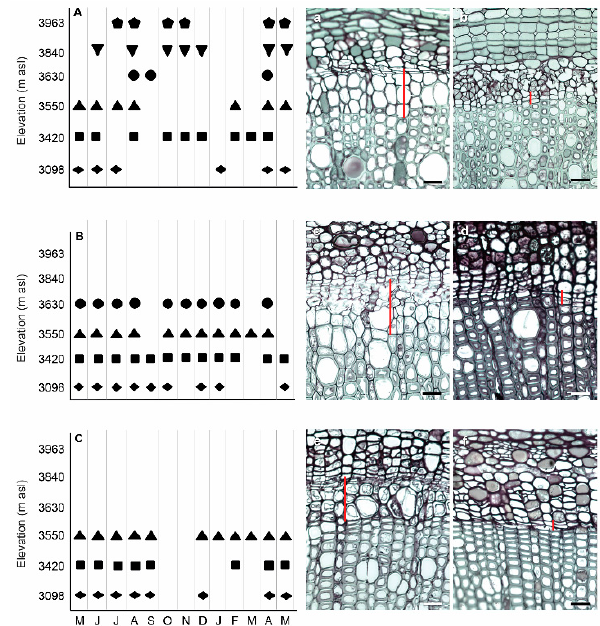
Figure 4. Cambial activity in the three species over the altitudinal gradient summarized for one year, May 2015 to May 2016. ( A ) Alchemilla procumbens , ( B ) Acaena elongata , ( C ) Ribes ciliatum . Symbols represent active cambium at each altitude. ( a , c , e ) = active cambium plus xylogenesis (vertical red line); ( b , d , f ) = inactive cambium (vertical red line). Scale bar is 20 μ m.